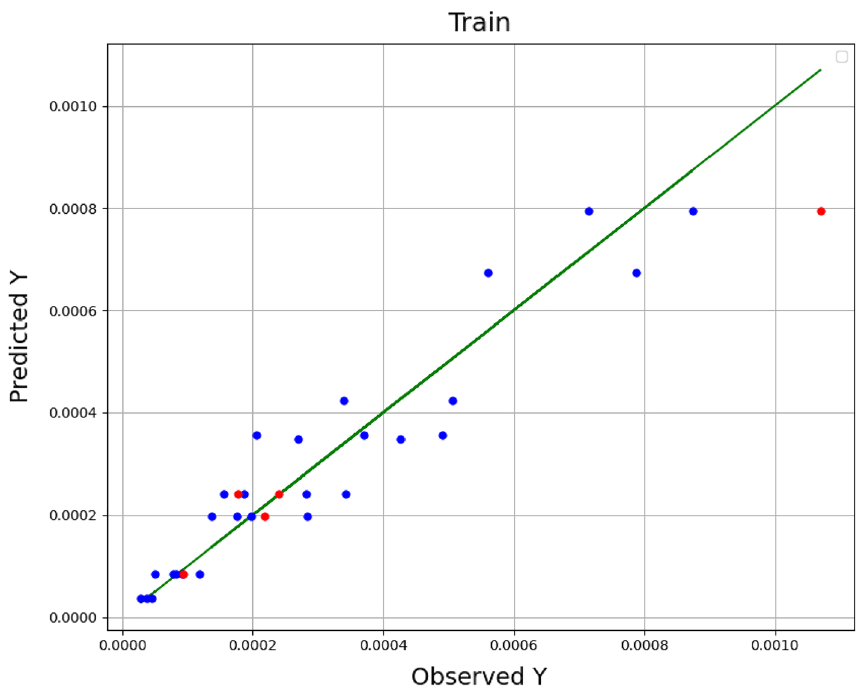
Figure 2. Observed vs estimated values (DTR) (Y: solubility/mole fraction).